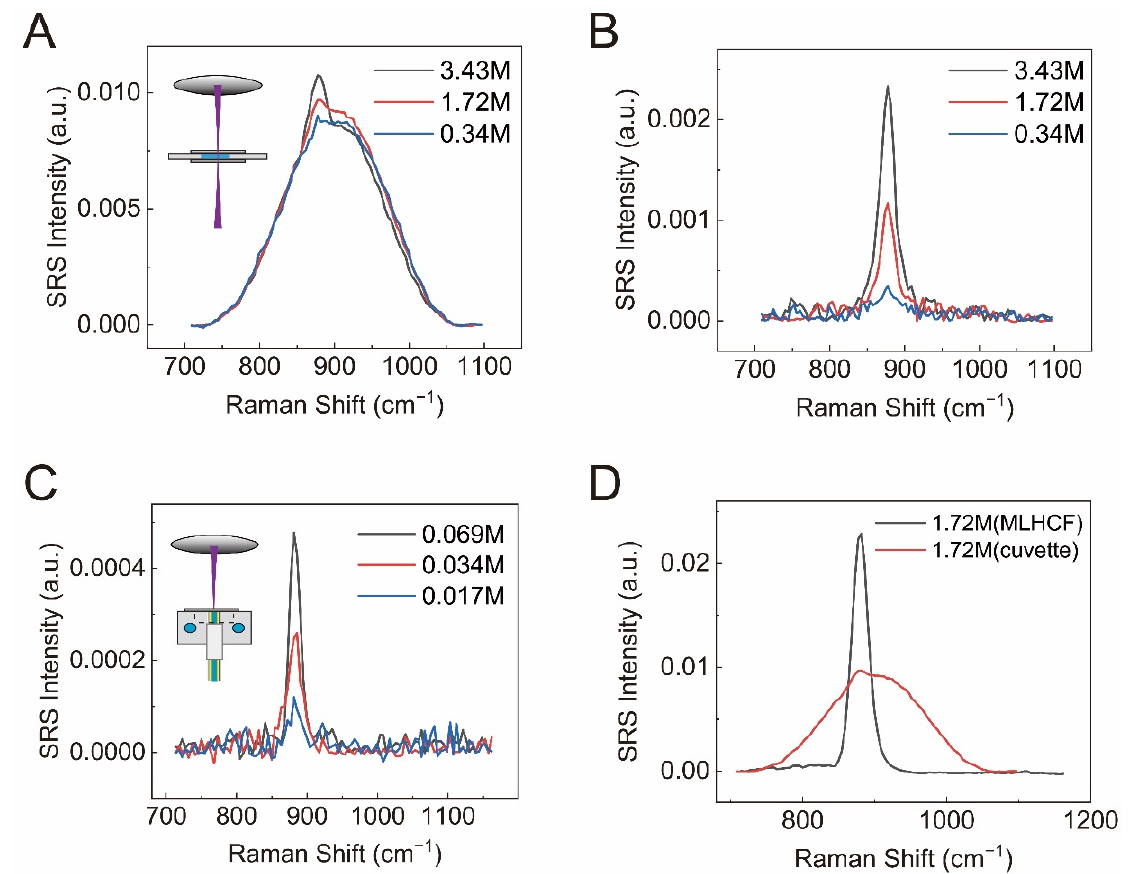
Figure 3. ( A ) Raw SRS spectra of ethanol with different concentrations for measurements in the cuvette; ( B ) background ‐ corrected SRS spectra of ethanol with different concentrations for measurements in the cuvette; ( C ) background ‐ removed SRS spectra (881 cm − 1 ) of ethanol with different concentrations via 8.3 cm long MLHCF; ( D ) SRS spectra of 1.72 M ethanol from the cuvette and the 8.3 cm fiber.